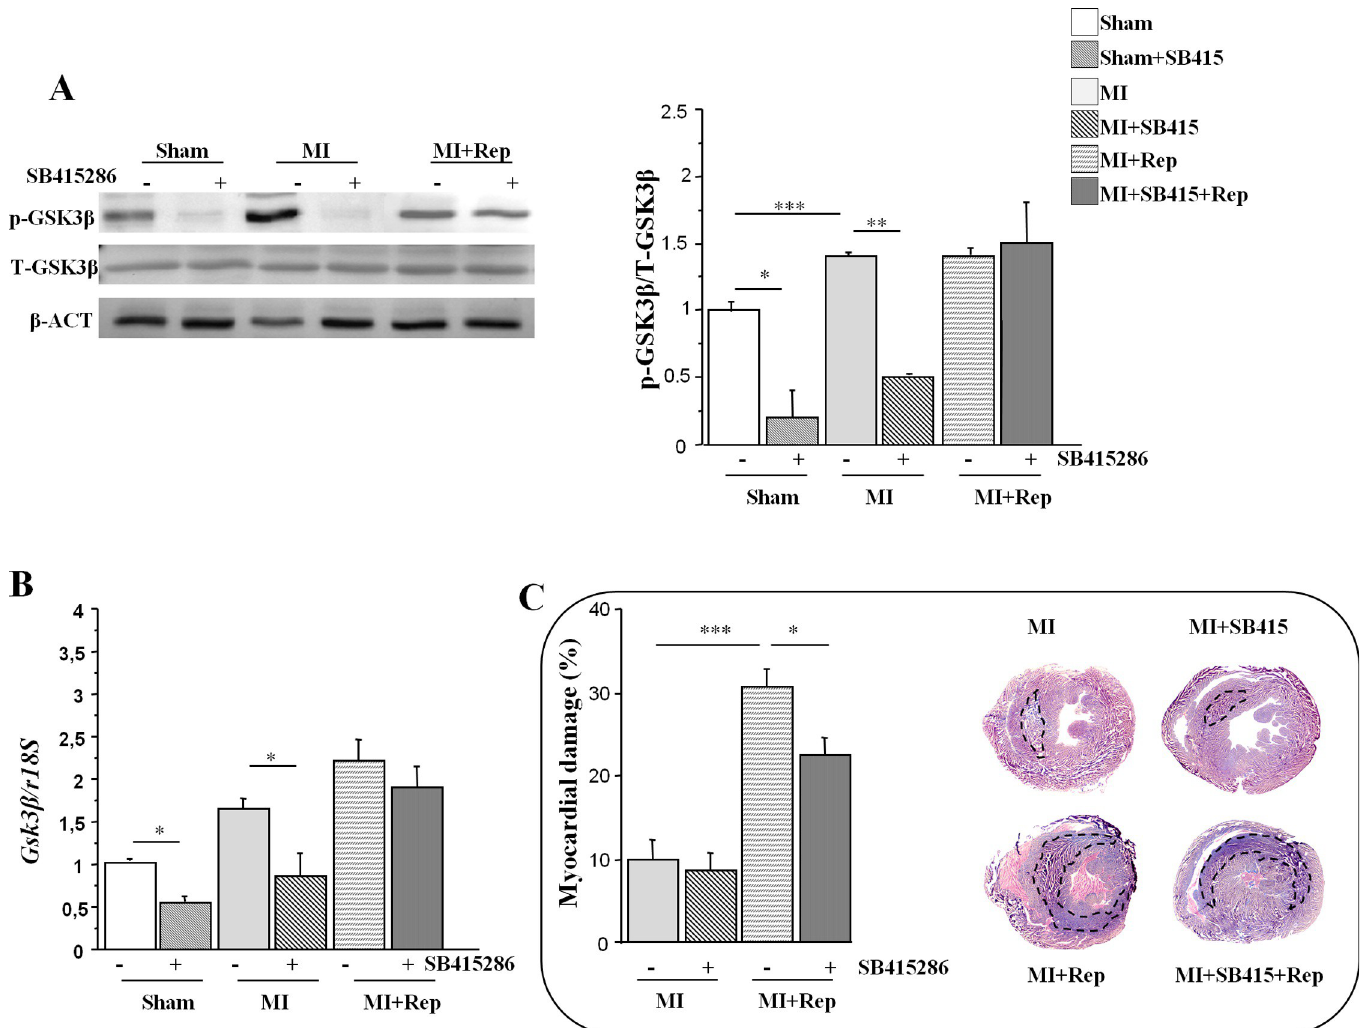
Fig 3. p-GSK3 β in ischemic hearts of Wt and Lrp5 -/- mice. (A) Protein levels of phosphorylated and total GSK3 β in hearts of Wt mice with or without 10mg/kg i.p. SB415286. p-GSK3 β /T-GSK3 β ratio of WB band intensities normalized with β -ACTIN. (B) mRNA expression (C) Myocardial damage assessment and representative images of Wt mice after MI and MI+Rep in the presence and absence of SB415286. 6–10 mice /condition � p < 0,05; �� p < 0,01; ��� p < 0,005.